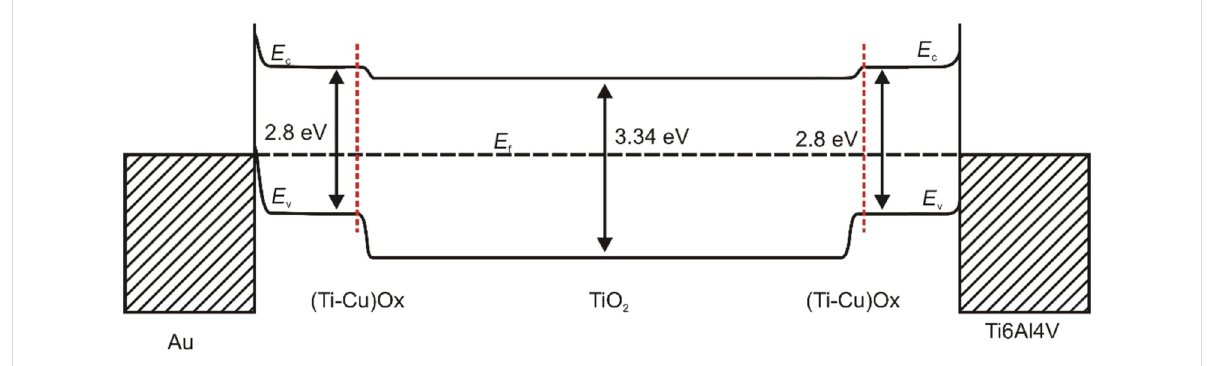
tion of conducting paths in the (Ti–Cu)Ox thin film. The results presented proved that thin films with a gradient element distri- bution profile can be an interesting configuration for the prepa- ration of devices utilizing memory